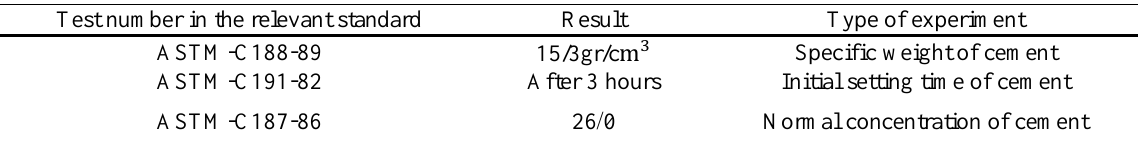
Table 1. Specifications of cement